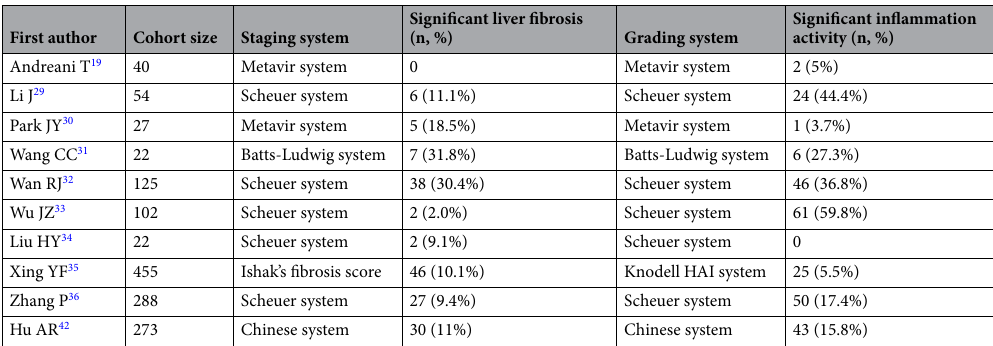
Table 2. Events and rate of significant histological